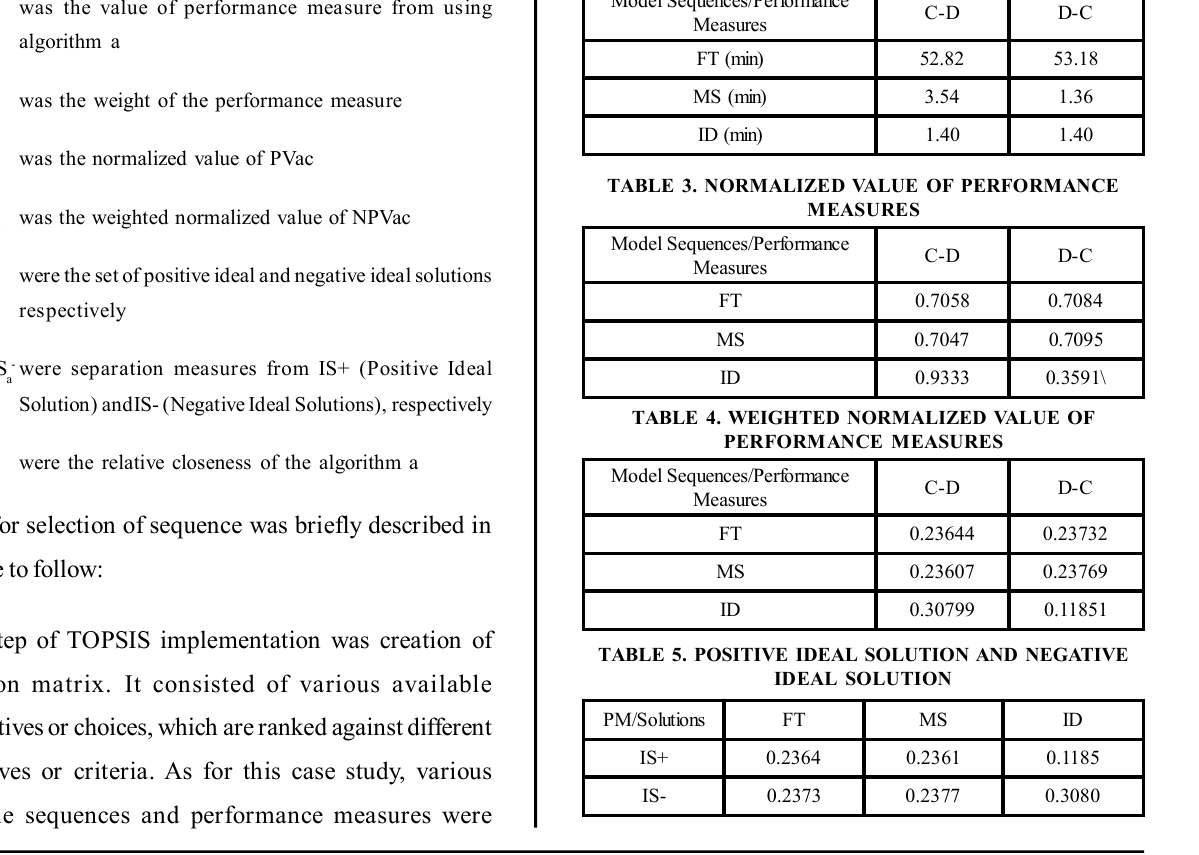
TABLE 2. DECISION MATRIX OF ALTERNATIVES AND CRITERIA